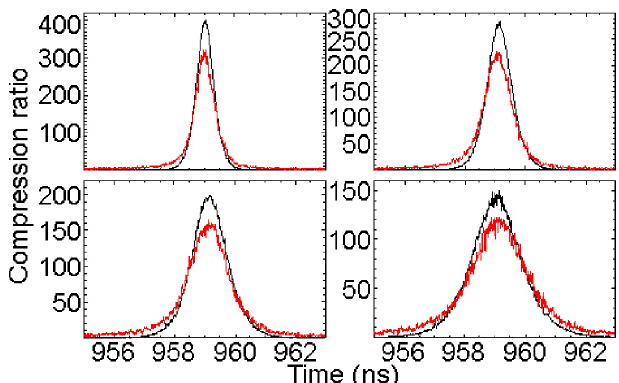
(cid:2) t (cid:3) =I comparison be- b 0